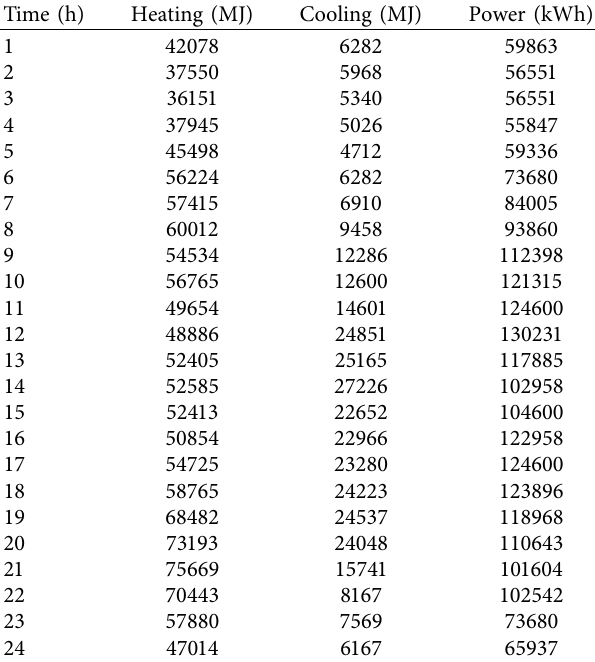
Table 3: Energy demand of spring/autumn typical